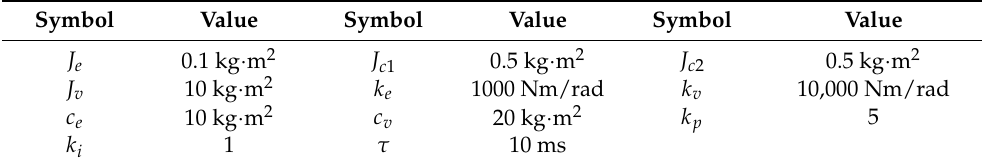
Table 1. Parameters used in the stability